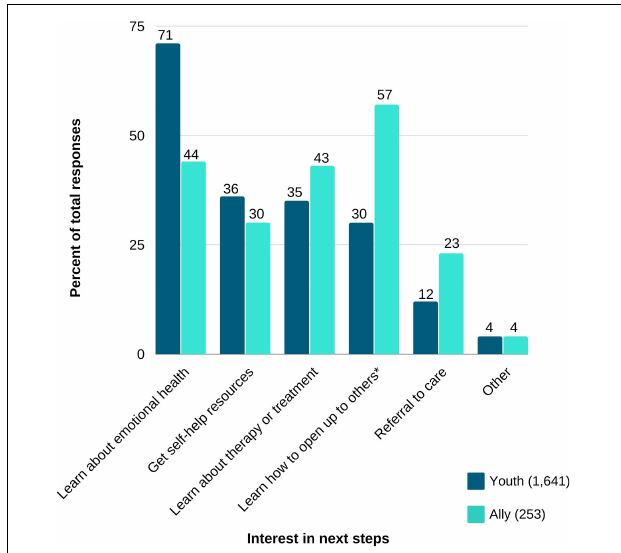
FIGURE 4 | User preferences grouped by youth and allies ( n = 1,894). *Ally selection was worded, “Learn how to talk to or support a loved